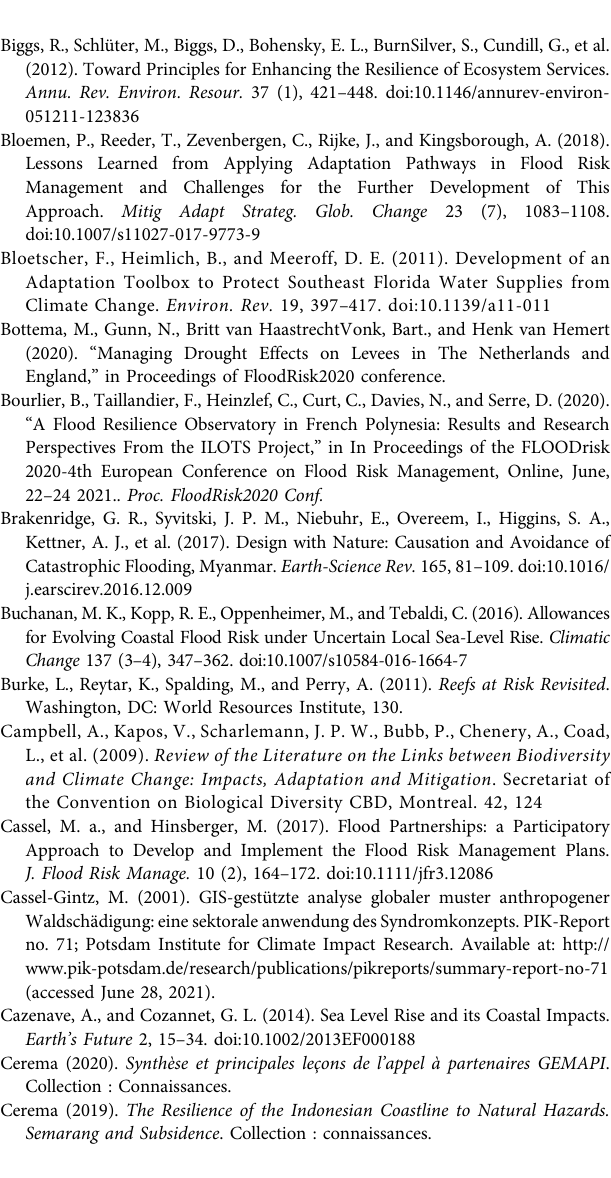
Supplementary Figure S1 | A breach in the Wilnis levee due to drought. Credit: STOWA. Supplementary Figure S2 | Double dike system (Marijnissen et al., 2021) SupplementaryFigureS3| Thetruefragilitycurvecomparedwiththedeterministic design (Sayers and Meadowcroft, 2005). Supplementary Figure S4 | An example of an adaptation pathways map (left) and a scorecard presenting the costs and bene fi ts of the nine possible pathways presented in the map (right). The colors in the scorecard refer to the actions A (red), B (orange), C (green), and D (blue) (Haasnoot et al., 2013). Supplementary Figure S5 | | Climate-resilient development pathway. From Hock, R., G. Rasul, C. Adler, B. Cáceres, S. Gruber, Y. Hirabayashi, M. Jackson, A. Kääb, S. Kang, S. Kutuzov, Al. Milner, U. Molau, S. Morin, B. Orlove, and H. Steltzer. In: IPCC, 2019, Figure CB2.2. Supplementary Figure S6 | The seven principles for managing the resilience of an SES (Bigg et al., 2012).